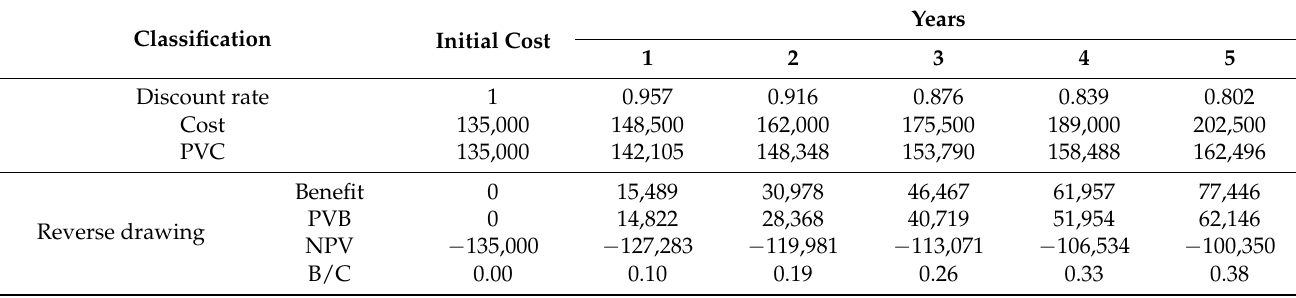
Figure 4. Cost–benefit ratio ( 𝐵𝐶𝑅 ) graph over 5 years. Table 8. CBA during the average lifecycle (5 years) of TLS (1000